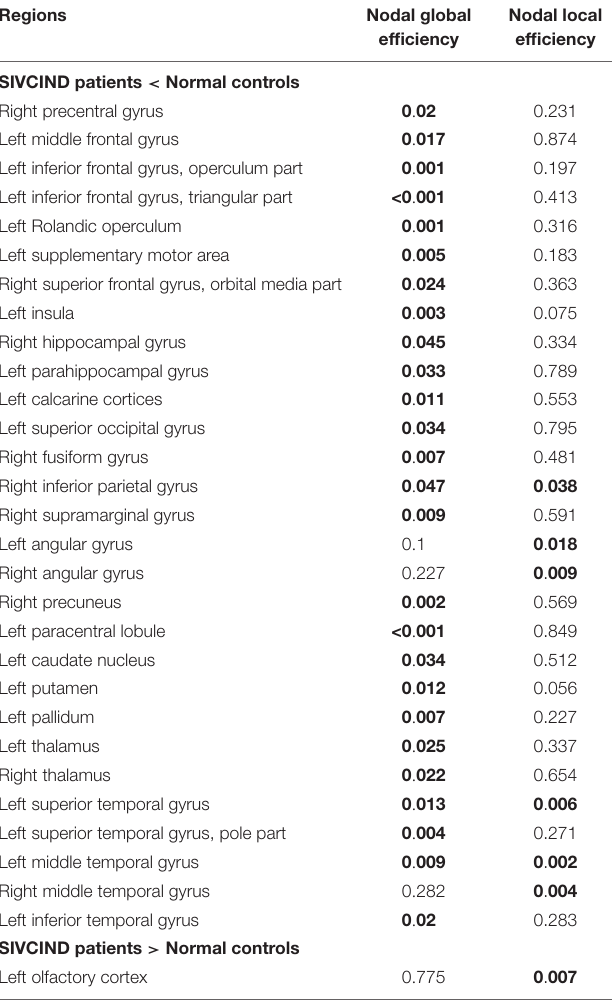
TABLE 2 | Brain regions showing abnormal nodal efficiency in SIVCIND patients compared with normal controls (FDR-corrected p < 0.05 shown in bold font). Regions Nodal global